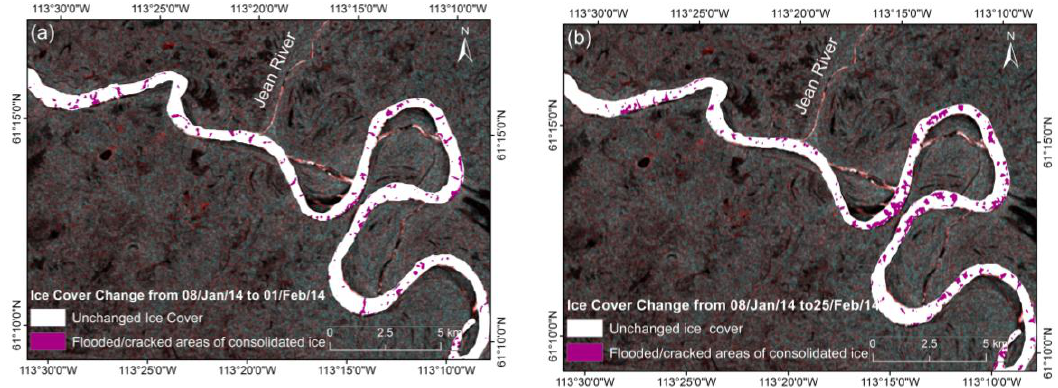
Figure 16. Flooded/cracked areas of ice cover on 1 February 2014 ( a ) and 25 February 2014 ( b ). (RADARSAT-2 Data and Products © MacDonald, Dettwiler and Associates Ltd. (2014)—All Rights Reserved. RADARSAT is an official trademark of the Canadian Space